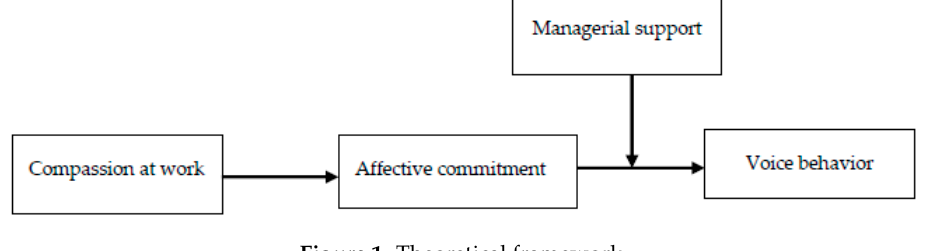
Figure 1. Theoretical framework.